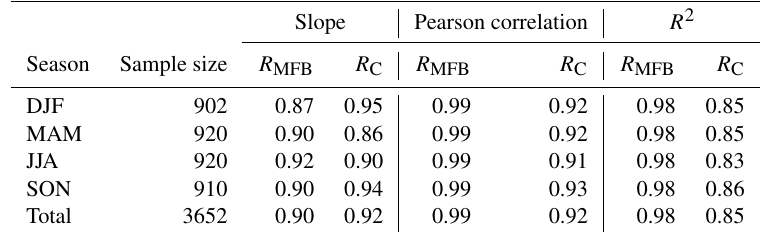
Table 2. Statistics of Fig. 5. Indicated are the sample size, the Pearson correlation and the slope of a linear fit between the reference and the two adjusted radar QPE products ( R MFB and R C ; the dashed colored lines in Fig. 5). This is indicated per season and for all seasons together (Total).